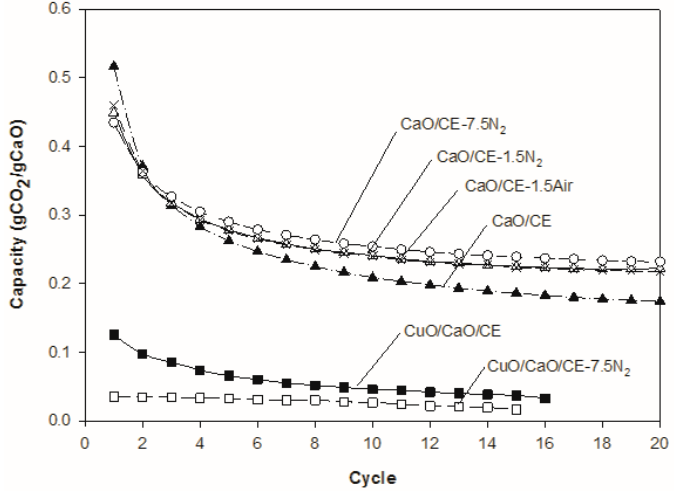
Figure 5. Impact of different thermal pretreatments on the performance of CaO/CE pellets over multiple CaL cycles, and of CuO/CaO/CE pellets over multiple CaL and CLC cycles. Each curve is the average of three runs.